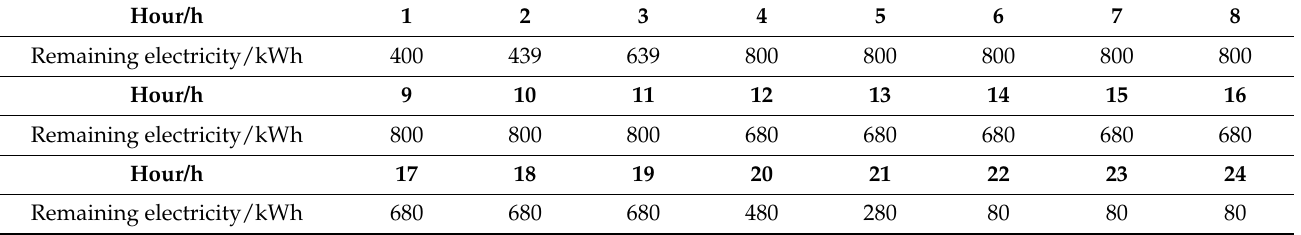
Figure 5. The final day-ahead economic scheduling scheme.